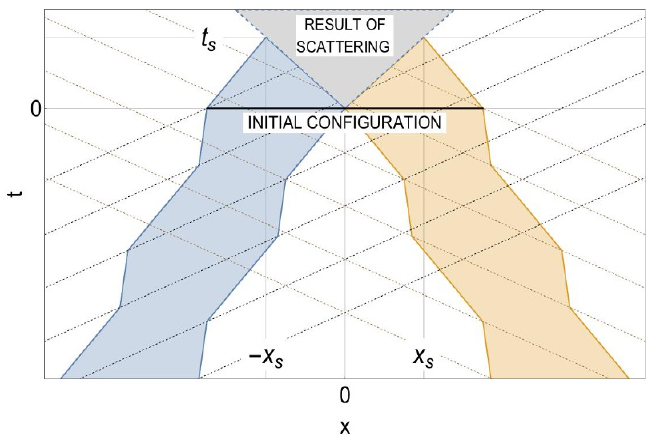
Figure 25 . Worldsheets of two incoming generalized oscillons with v 6 = 0. The oscillons are unperturbed inside two triangular regions above the line t = 0. The zeros of each oscillon correspond to the intersections of its worldsheet with a family of dashed